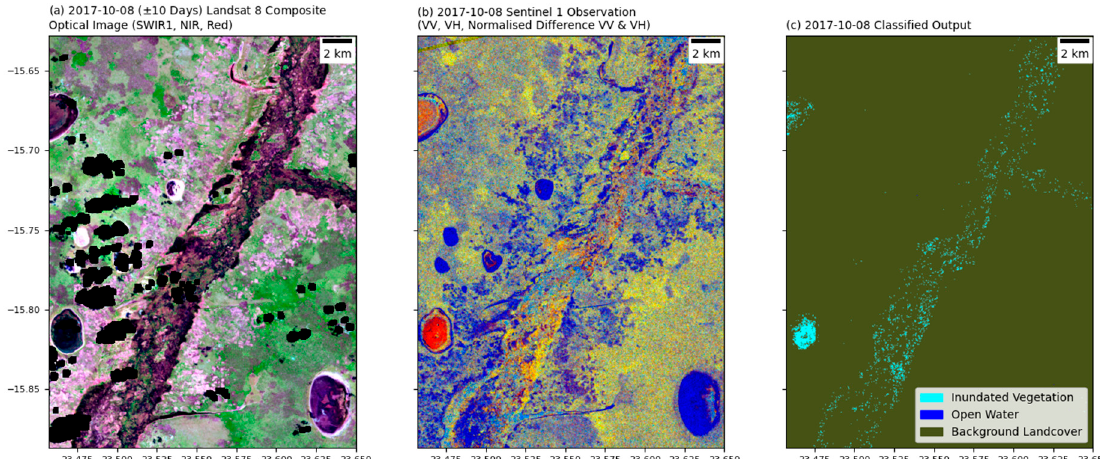
Figure 11. ( a ) Landsat 8 composite (False Colour: NIR, SWIR1, Red), ( b ) Sentinel-1 Observation (False Colour: VV, VH, NDPI) and ( c ) RadWet output product dated 8 October 2017 showing a section of the Lui river within the Barotseland Floodplain where inundated vegetation can be observed within the Landsat 8 composite, but the typical red/orange double-bounce signature is not present in the Sentinel-1 Observation.